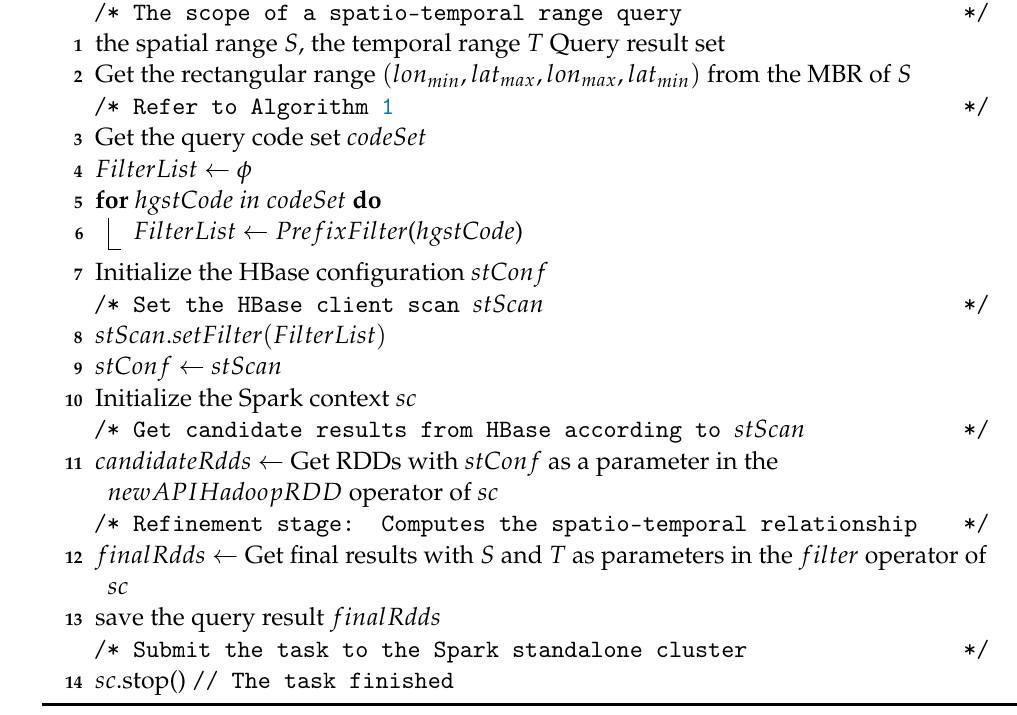
Algorithm 5: Spark-based method for the refinement stage of trajectory spatio- temporal range